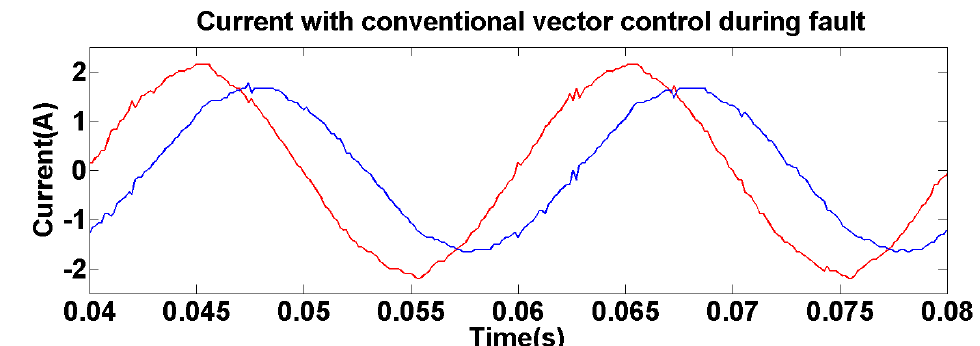
Figure 12. Current after fault with conventional vector control.